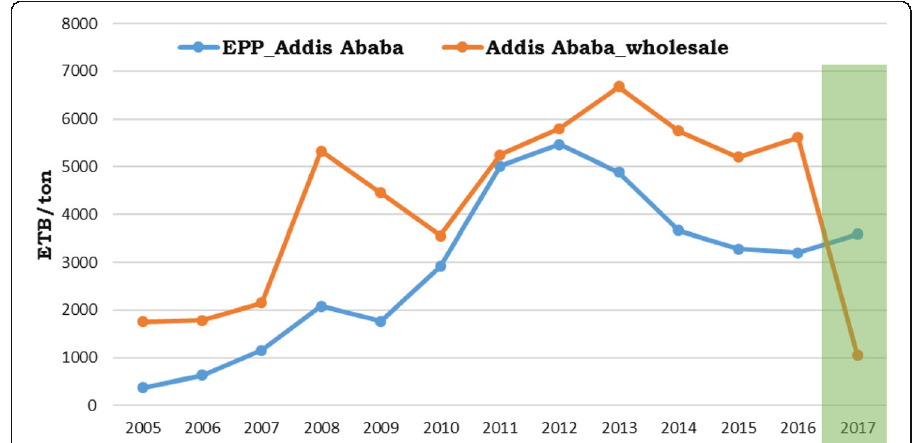
Fig. 4 White maize export parity price analysis with scenario 1, 2005 – 2017. Note: Export parity analysis is calculated using the US No 2, yellow maize, Gulf of Mexico. Source: Author ’ s